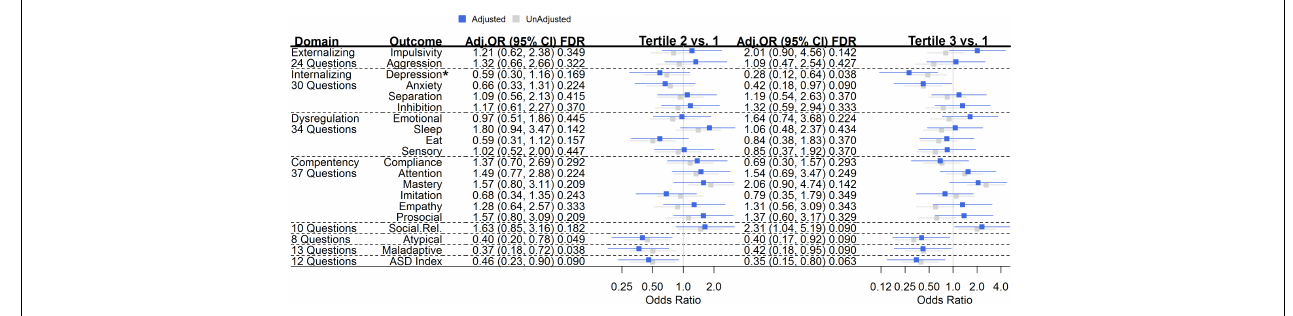
FIGURE 1 | Maternal Mediterranean Diet Adherence (MDA) and Child Behavior Outcomes. For a given tertile of maternal MDA compared to tertile 1 (referent), the odds ratio (95% confidence interval) represents the risk of being in a higher tertile of behavioral outcome. Unadjusted (gray) and adjusted (blue) odds ratios (95% confidence intervals) are plotted. Estimates were adjusted for breastfeeding at least 3 months, age of child at behavioral assessment, maternal fiber intake, total calories, folate, education, diabetes, obesity, smoking, and age, as well as paternal age and child parity, premature birth, weight, race, and child sex. Q- values are shown and represent the false discovery rate (FDR) for each finding, which is automatically corrected for multiple testing. ∗ Bonferroni-corrected p -trend =